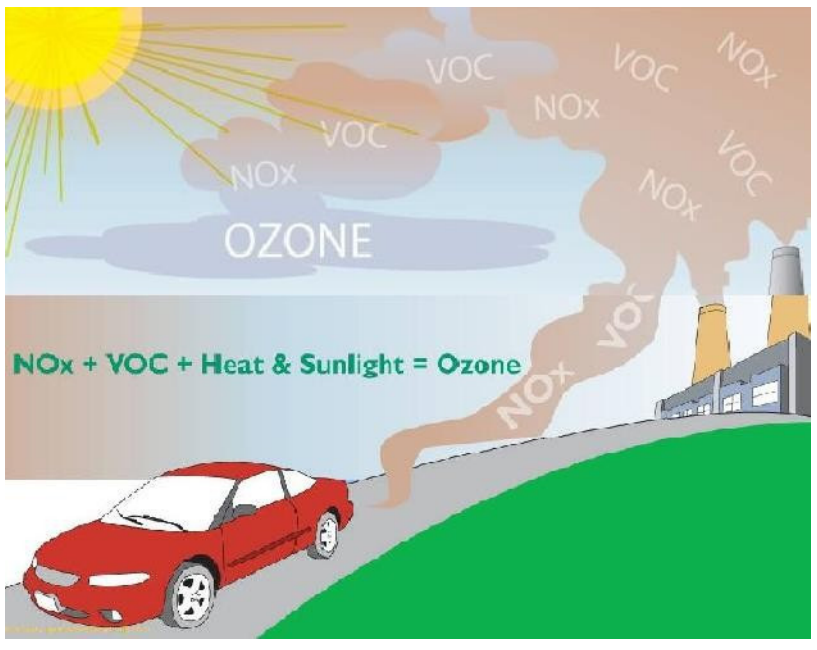
Figure 2. Formation of ozone.